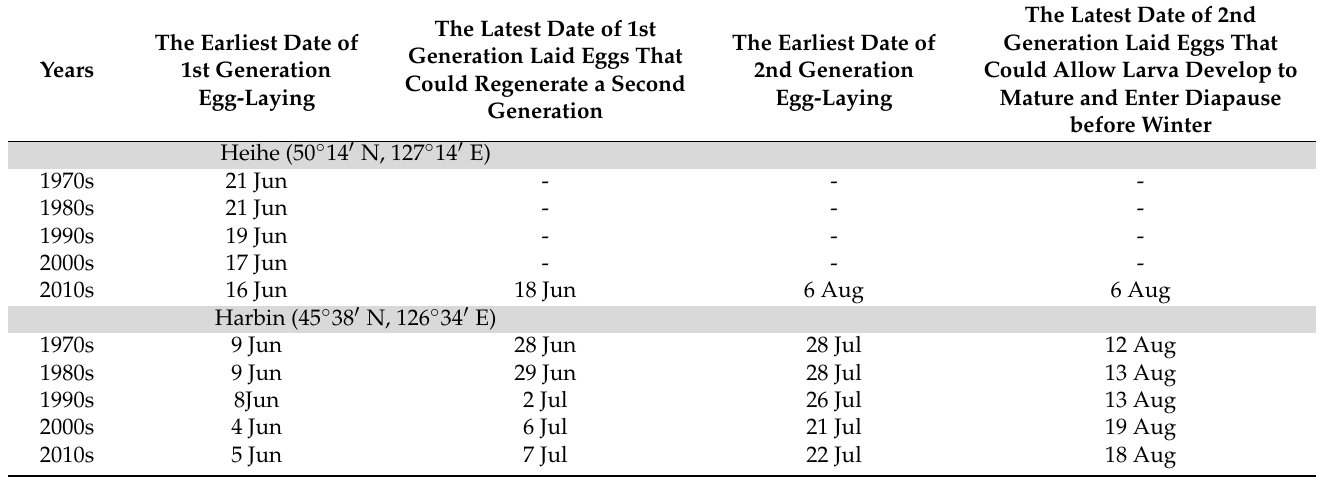
Table 1. Predicted dates of generational events during five 10-yr periods in Heihe and Harbin.